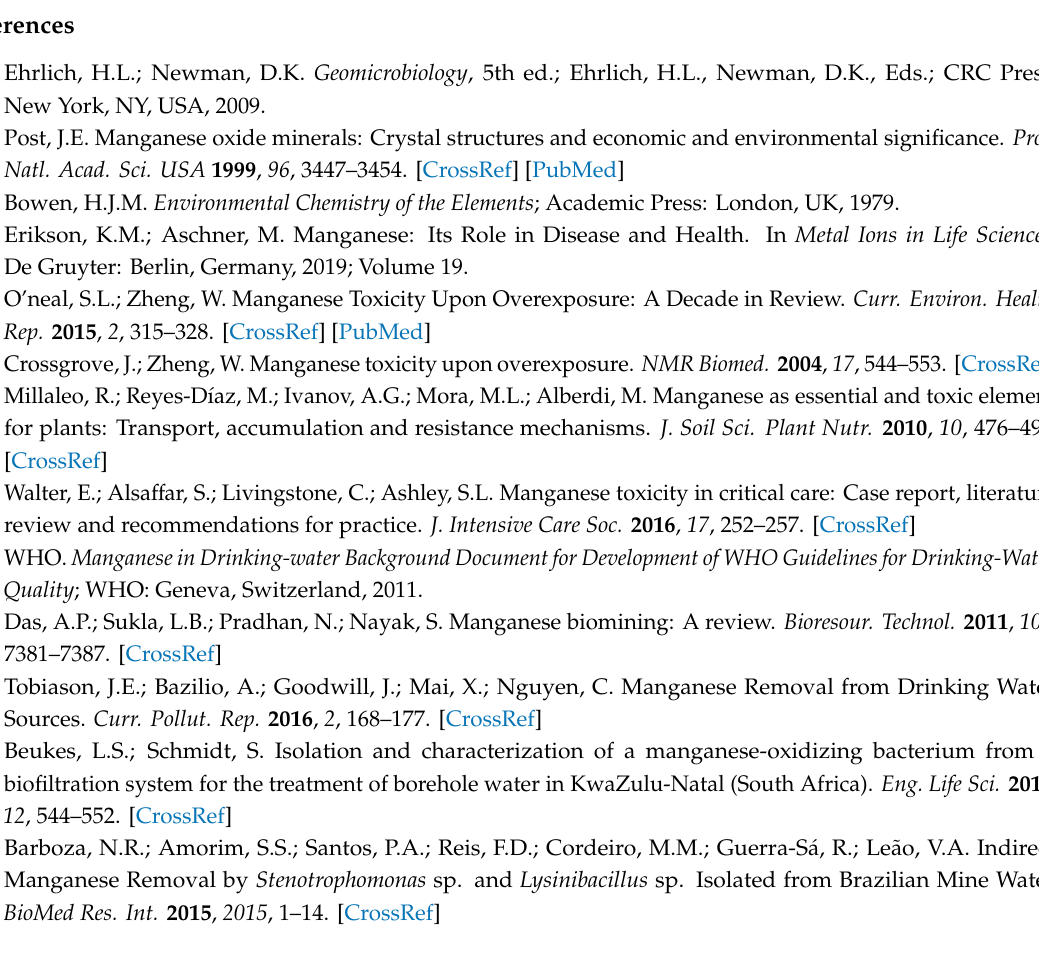
Figure S1: Changes of dissolved Mn, pH, and OD of abiotic control basal salt medium (a) and nutrient broth medium (b), Figure S2: Comparison of Mn removal e ffi ciency by five isolated